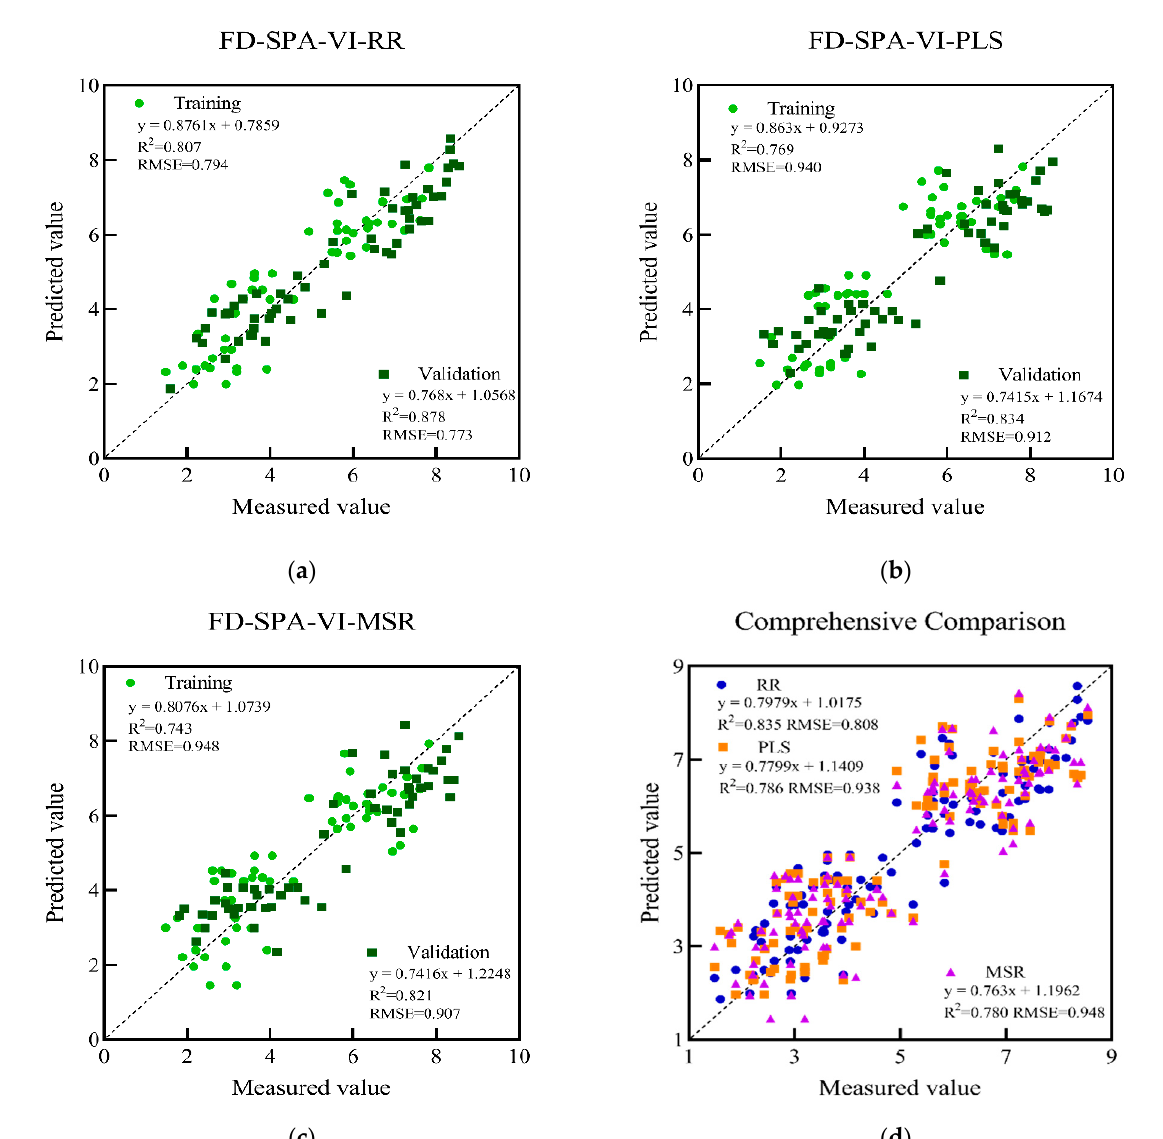
Figure 7. Inspection results based on the three modeling methods of FD-SPA-VI. ( a ) FD-SPA-VI-RR model; ( b ) FD-SPA-VI-PLS model; ( c ) FD-SPA-VI-MSR model; ( d ) comprehensive comparison of three models. The total number of samples for LAI was 120, 60 training sets and 60 validation sets.